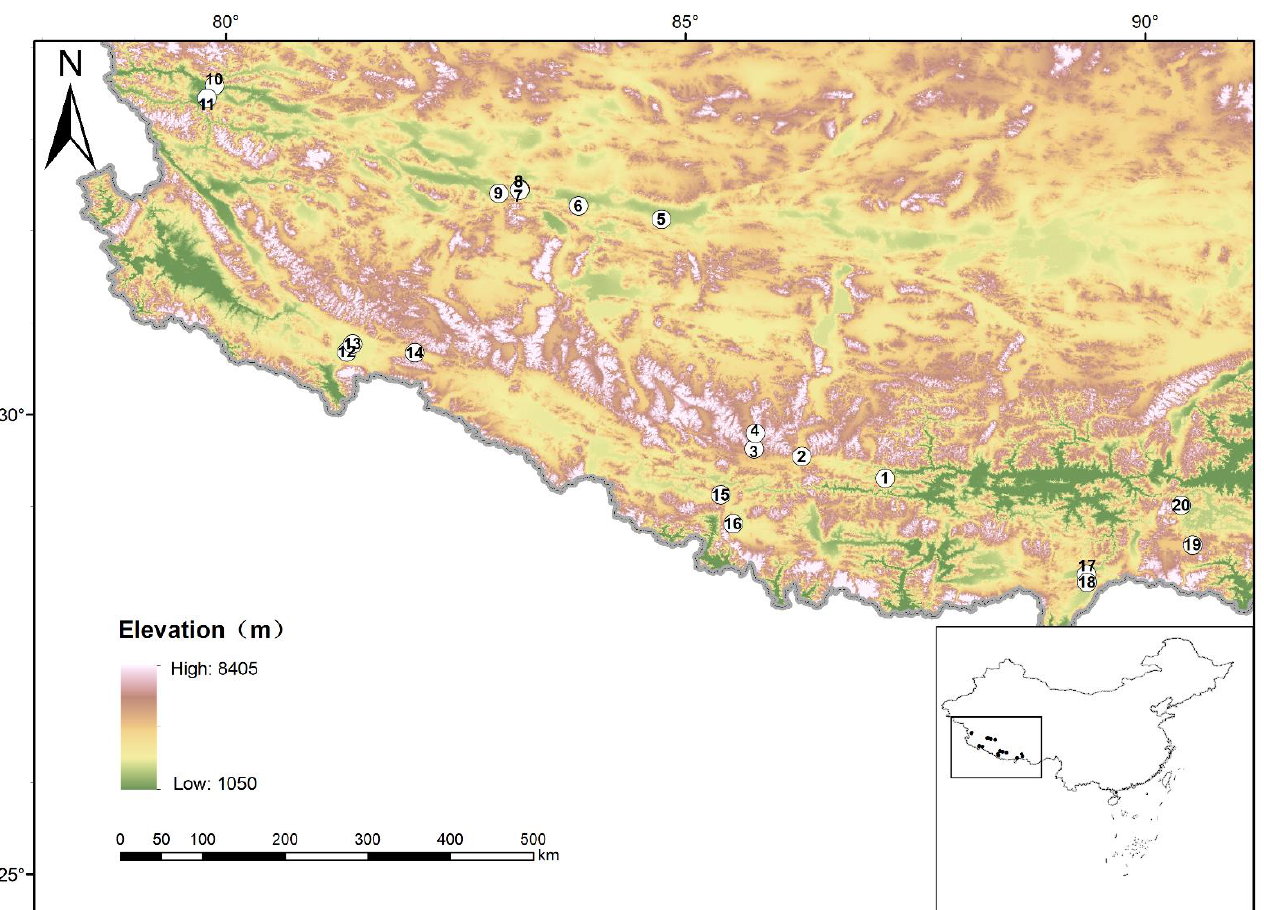
Figure 1. Location of the 20 sites on the Qinghai-Tibetan Plateau that were investigated and sampled in this study. The inset map in the bottom right corner shows the study area on a map of China.